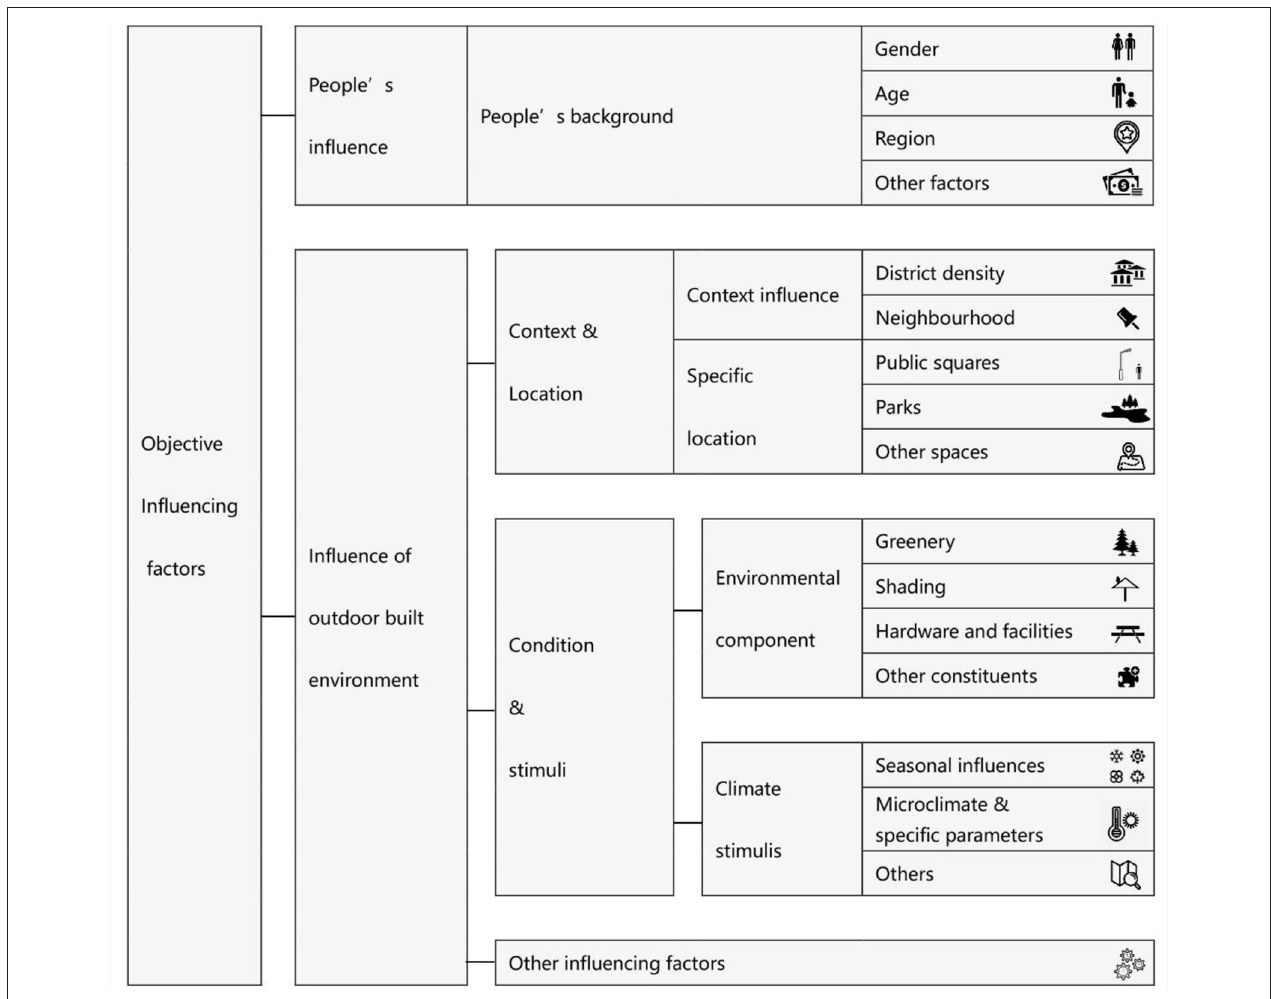
FIGURE 2 | Objective influencing factors frequently investigated in public open